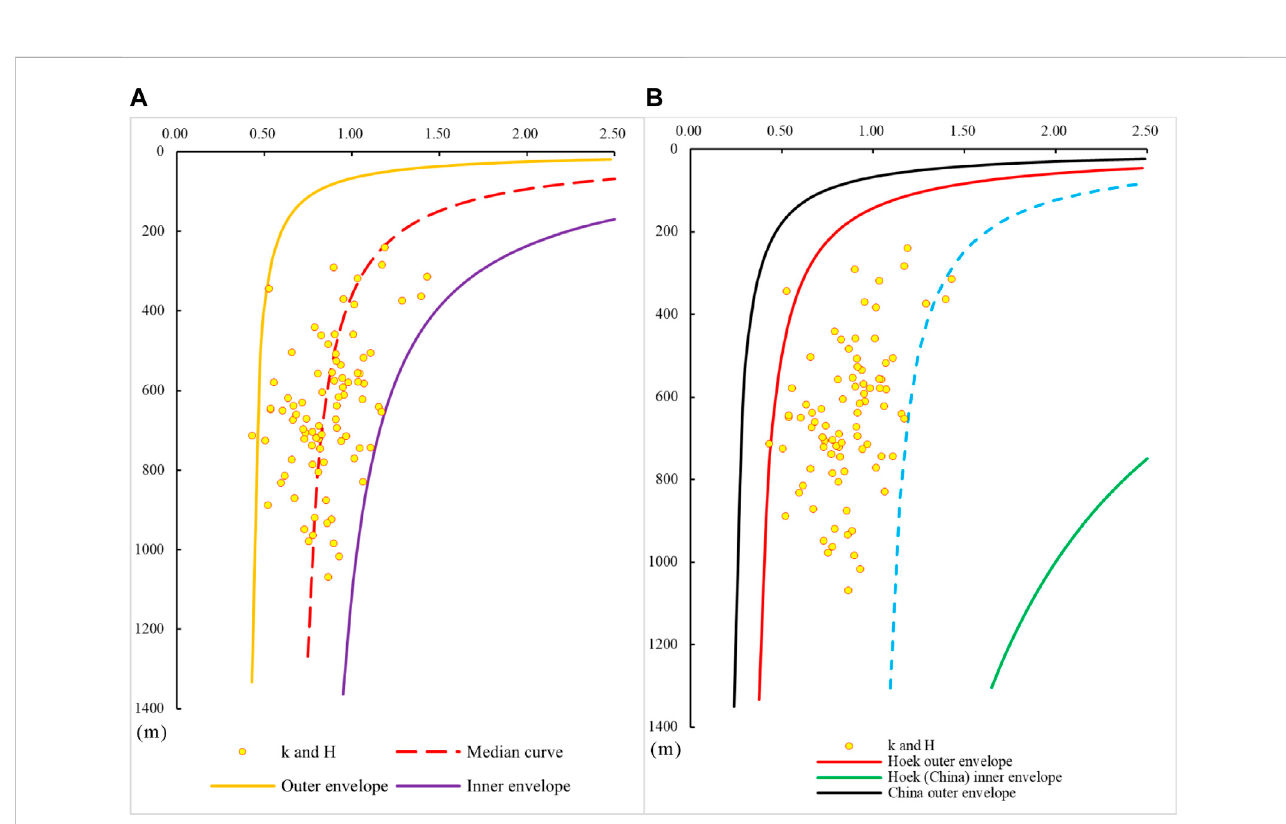
Hyperbolic fi tting relationship between k value and depth in western